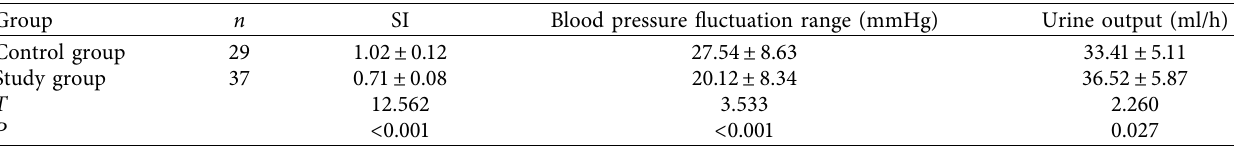
Table 2: Comparison of SI, blood pressure fluctuation range, and urine output between the control group and the study group after 18 hours of treatment ( x ± s